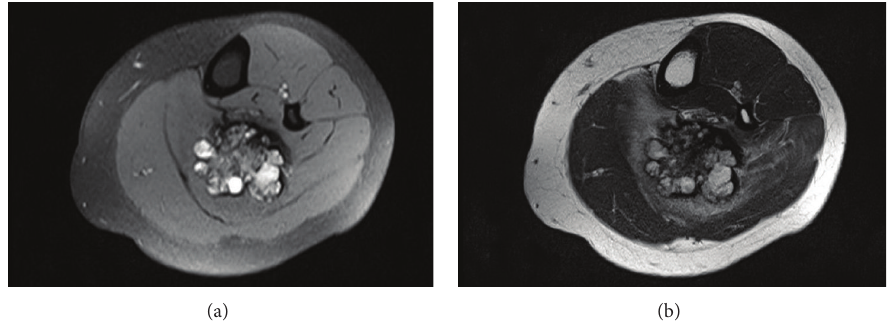
Figure 1: T1 weighted fat suppressed (a) and T2 (b) images of the left lower extremity, with no intravenous contrast, showing a deep-seat posterior ankle well-circumscribed ovoid mass centered in the soleus muscles measuring 6.8 cm in the craniocaudal dimension, 5.2 cm in the transverse oblique dimension, and 4.6 cm in the oblique dimension, with lobulations and septations, as well as heterogeneous signal intensity on T1 and T2 weight images, suggestive of a